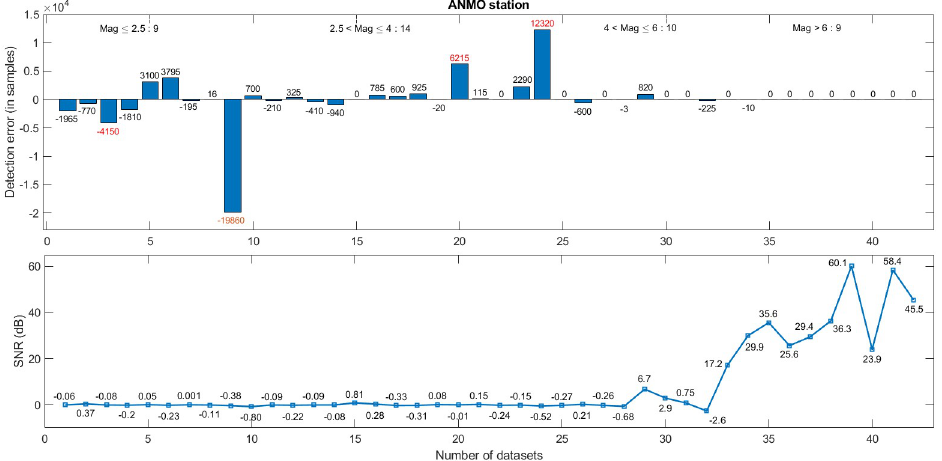
Fig 9. ANMO station: Event detection vs SNR. Top and bottom figures depict the detection error and SNR, respectively.